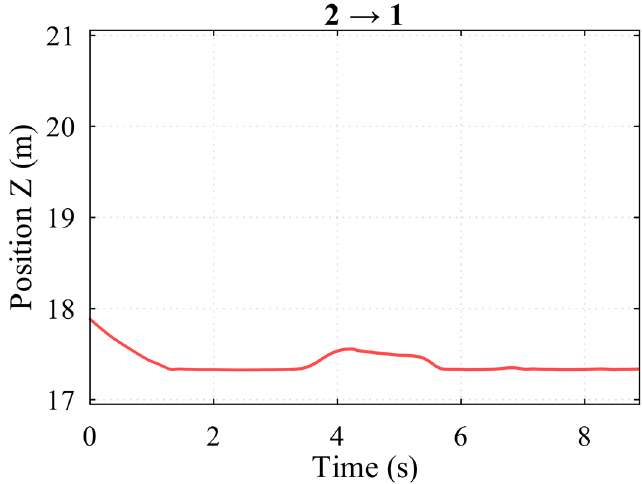
Figure 7. Spreader trajectory along the Z-axis: Example B.